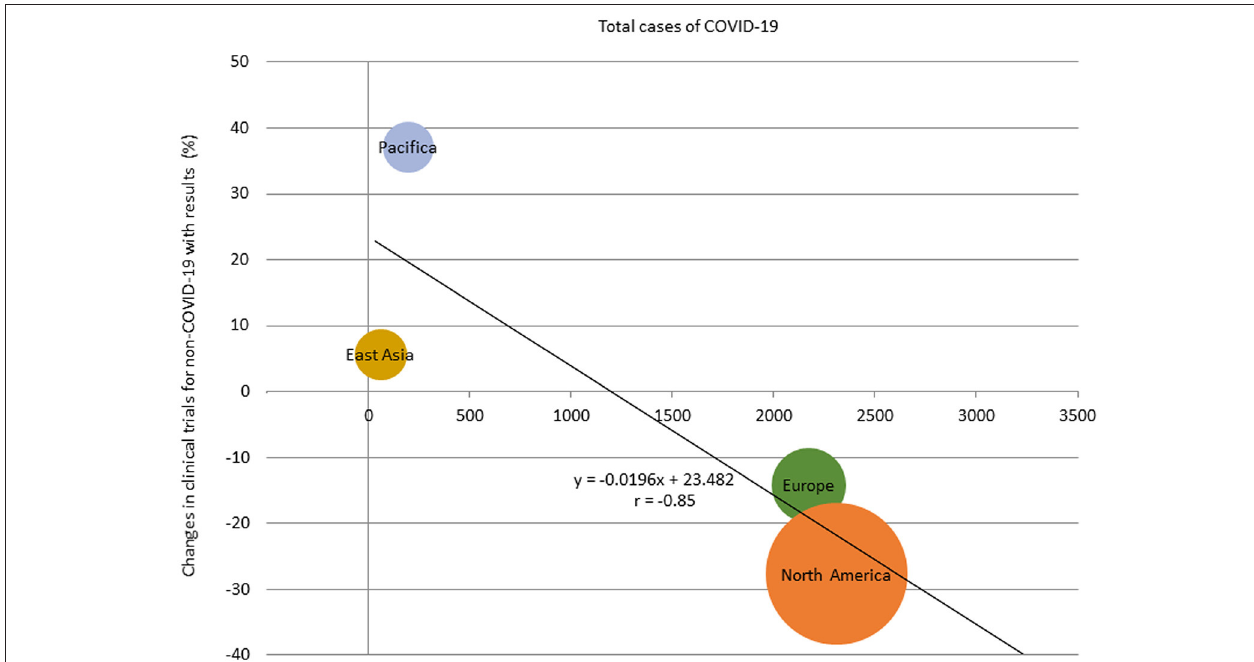
FIGURE 4 | Relationship between total cases of COVID-19 and percentage change of the number of clinical trials with results in regions with more than 30 studies, May 2020. The size of the bubbles reflected the number of